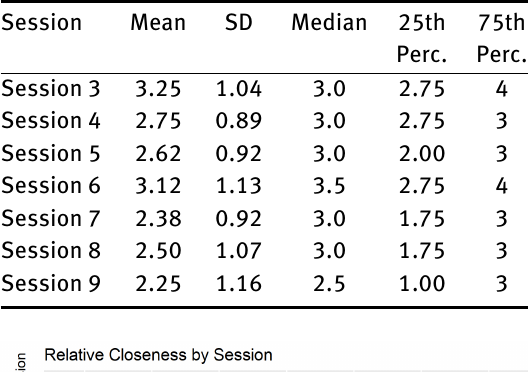
Figure 9: Relationship across sessions measured by IOS Scores by Session. Table 7: Relative Closeness by Session.